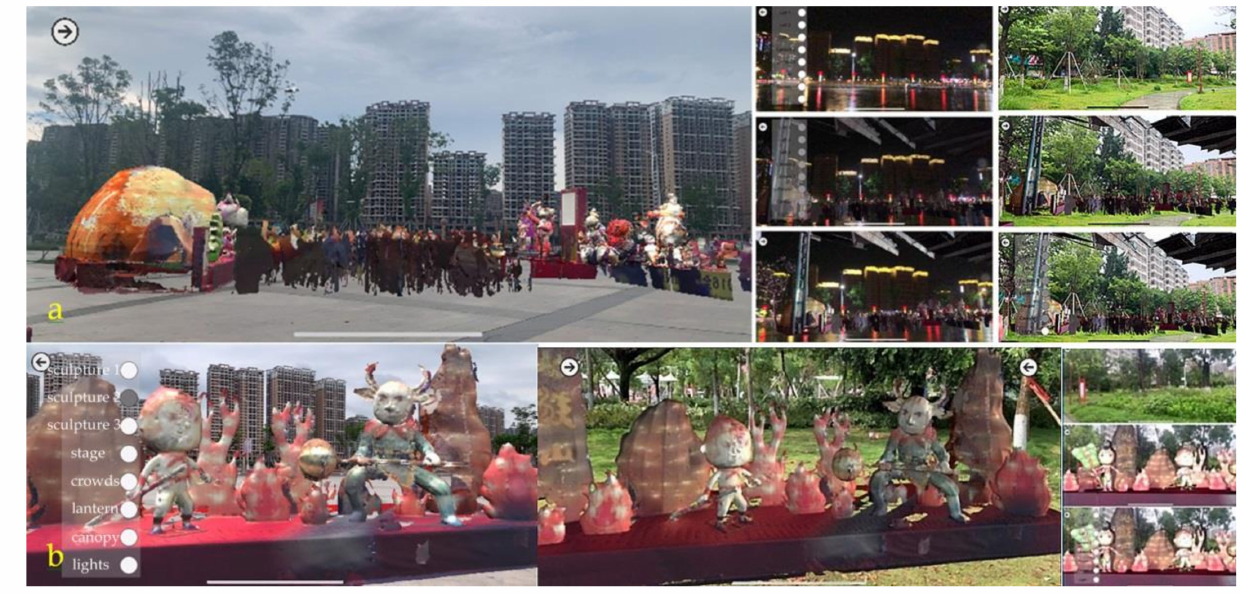
Figure 11. The two-axis spatial structure ( a ) or individual lantern ( b ) was combined with different real environmental contexts in the evening or in the